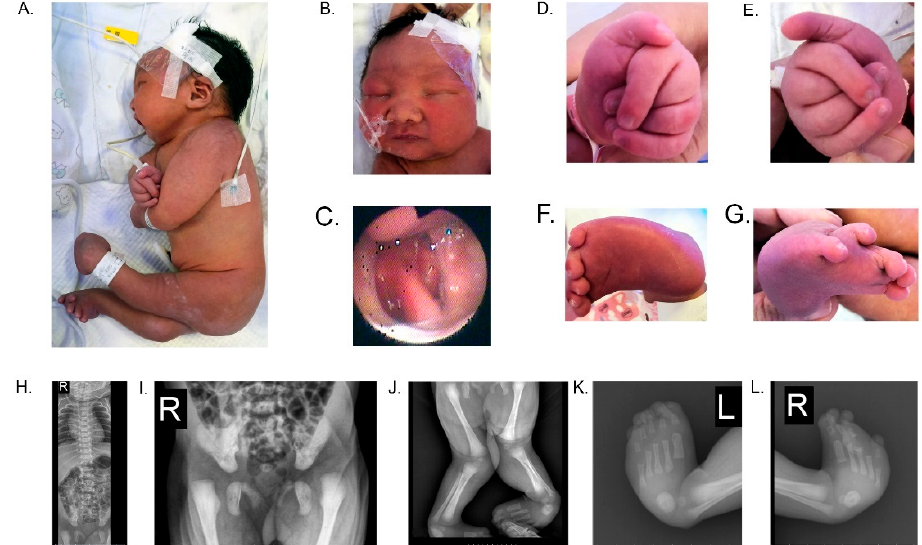
Figure 1. Clinical features of the female proband. Images of the patient 4 days after birth revealed: ( A ) a short neck, and AMC including shoulders in adduction, elbows in flexion, hip joints in flexion, knees in extension, radial and ulnar digital deviation, severe congenital club-feet, and limb spasticity, together with laying naturally on her side; ( B ) hypertelorism, micrognathia, and retrognathia; ( C ) cleft palate with a split of the uvula and soft palate, and a partial split of the hard palate, as observed by laryngoscopy; ( D ) radial and ulnar digital deviation of the left hand; ( E ) radial and ulnar digital deviation of the right hand; ( F ) severe left club foot; and ( G ) severe right club foot and ectopic fourth toe. At 3 days, the X-ray analysis showed: ( H ) no apparent bone abnormalities in the spine; ( I ) bilateral hip dysplasia; ( J ) X-shaped deformity of both lower extremities, end-swelling of both femurs, tibiae, and fibulae with increased bone density; ( K ) left varus foot and increased calcaneal bone density; and ( L ) right varus feet, increased calcaneal bone density and an ectopic fourth toe.